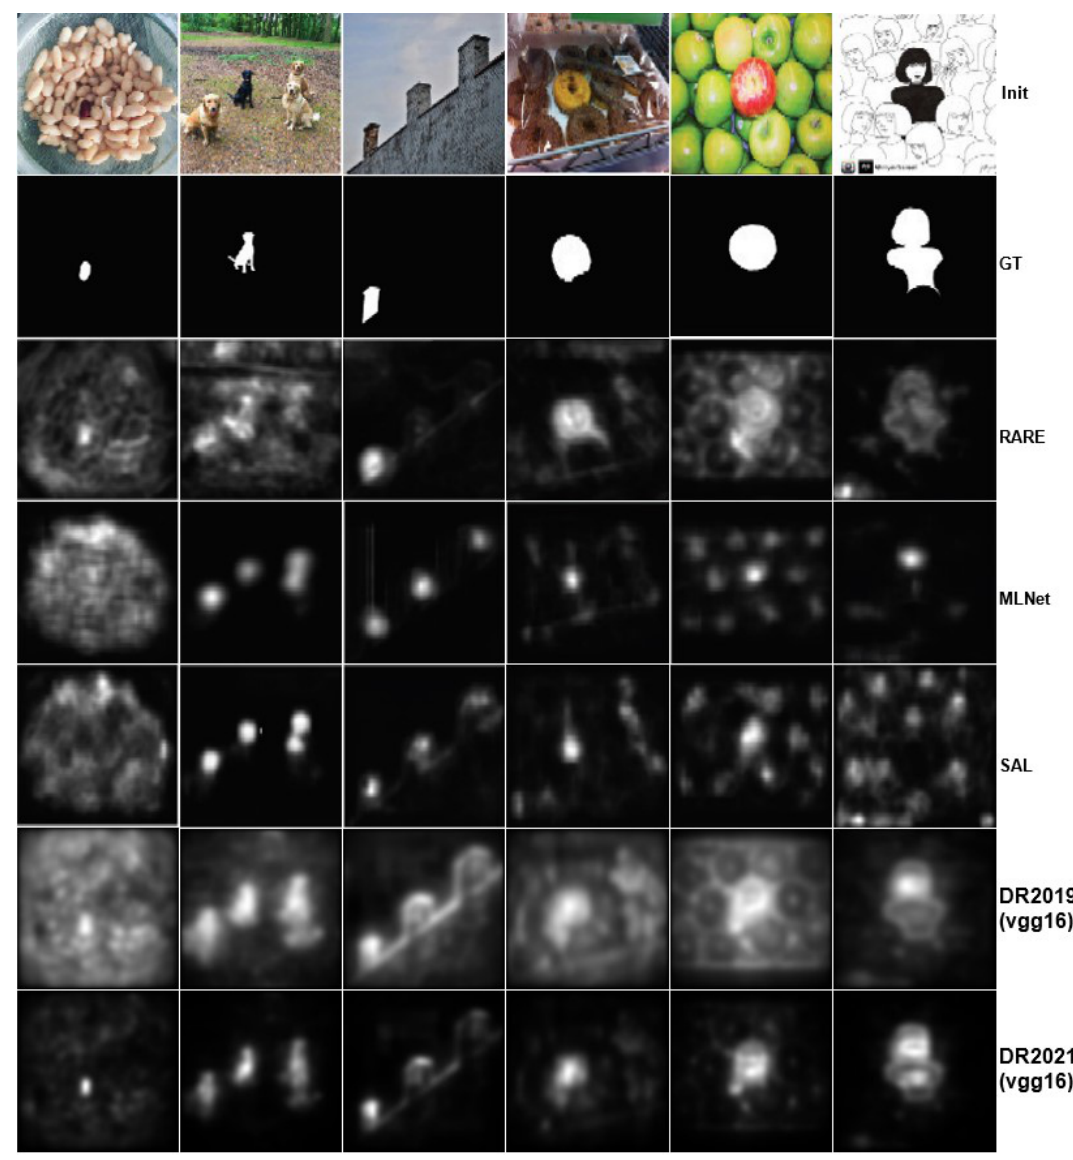
Figure 8. Selected samples O 3 dataset. From top to down: initial, ground truth, RARE2012, MLNET, SALICON, DR2019,